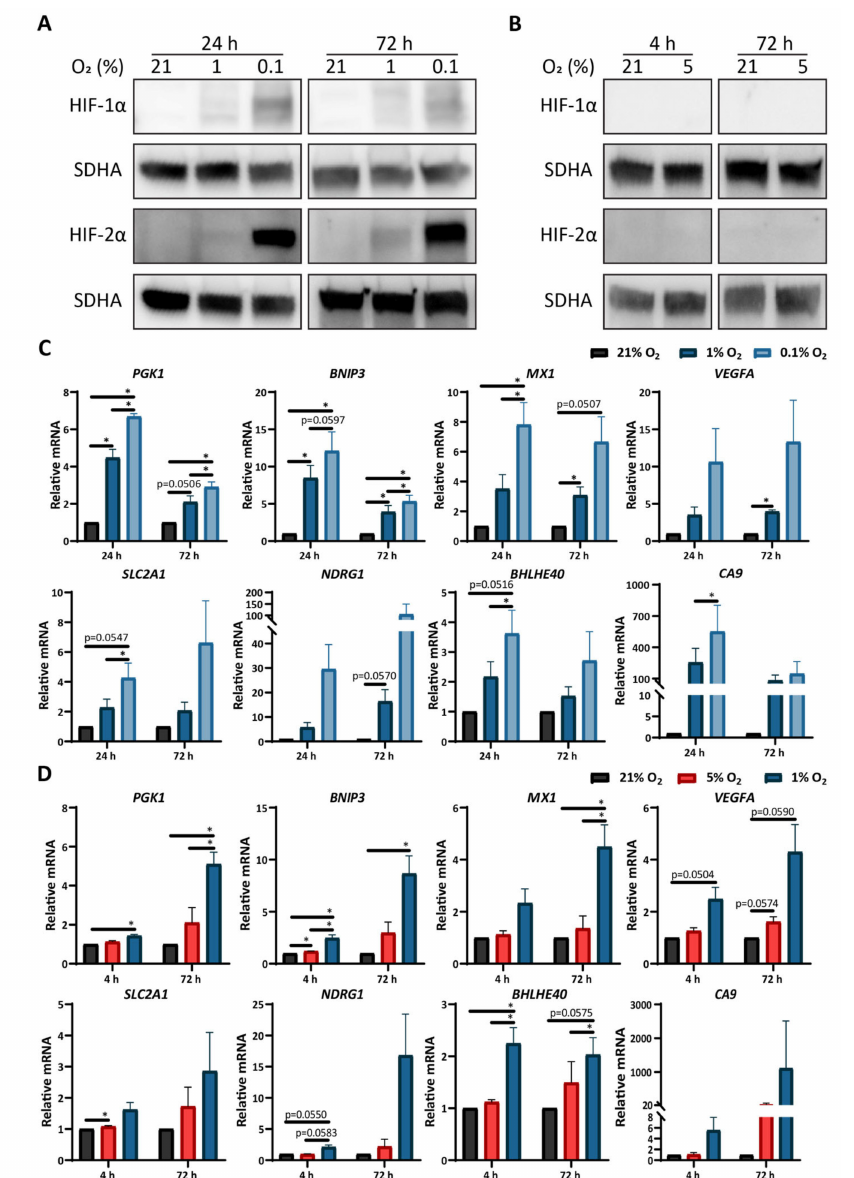
Figure 2. Low oxygen tension induces a strong hypoxic response in astrocytes. ( A ) Representative images of Western blots showing HIF-1 α , HIF-2 α , and SDHA (loading control) expression in astro- cytes cultured for 24 or 72 h at 21%, 1%, or 0.1% O 2 . ( B ) Representative images of Western blots showing HIF-1 α and HIF-2 α expression in astrocytes cultured for 4 or 72 h at 21% or 5% O 2 . ( C ) qPCR data for relative mRNA expression of PGK1 , BNIP3 , MX1 , VEGFA , SLC2A1 , NDRG1 , BHLHE40 , and CA9 in astrocytes cultured for 24 or 72 h at 21%, 1%, or 0.1% O 2 . * p ≤ 0.05 vs. normoxic controls, one-way ANOVA (Tukey’s multiple comparisons test). ( D ) qPCR data for relative mRNA expression of PGK1 , BNIP3 , MX1 , VEGFA , SLC2A1 , NDRG1 , BHLHE40 , and CA9 in astrocytes cultured for 4 or 72 h at 21%, 5% O 2, or 1% O 2 . * p ≤ 0.05 vs. normoxic controls, one-way ANOVA (Tukey’s multiple comparisons test). All data represent mean ± SEM. All data represent one replicate from three independent astrocyte